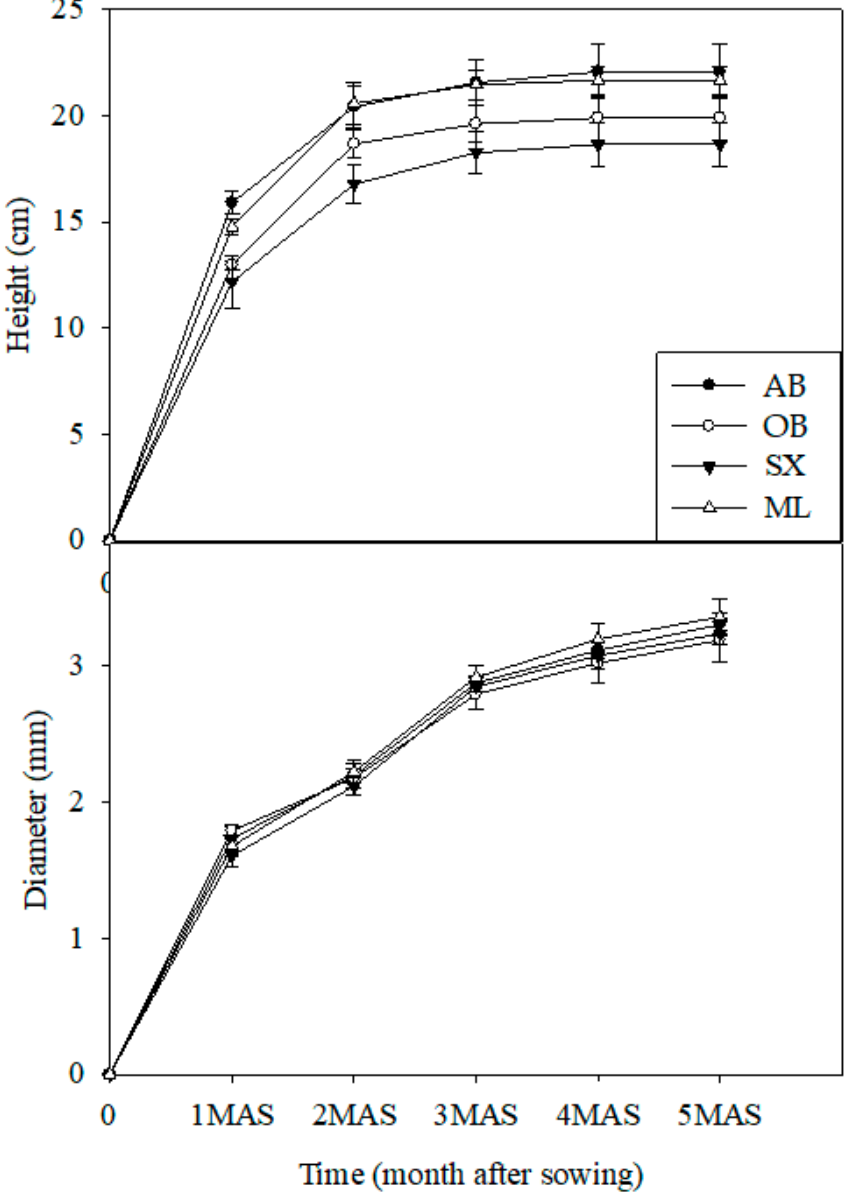
Figure 2. Monthly seedling growth in height and diameter of four provenances of X. sorbifolium . AB—Ar Horqin Banner; OB—Ongniud Banner; SX—Shanxian; ML—Mulei. Bars marked with different letters differ significantly according to Duncan’s test α = 0.05.